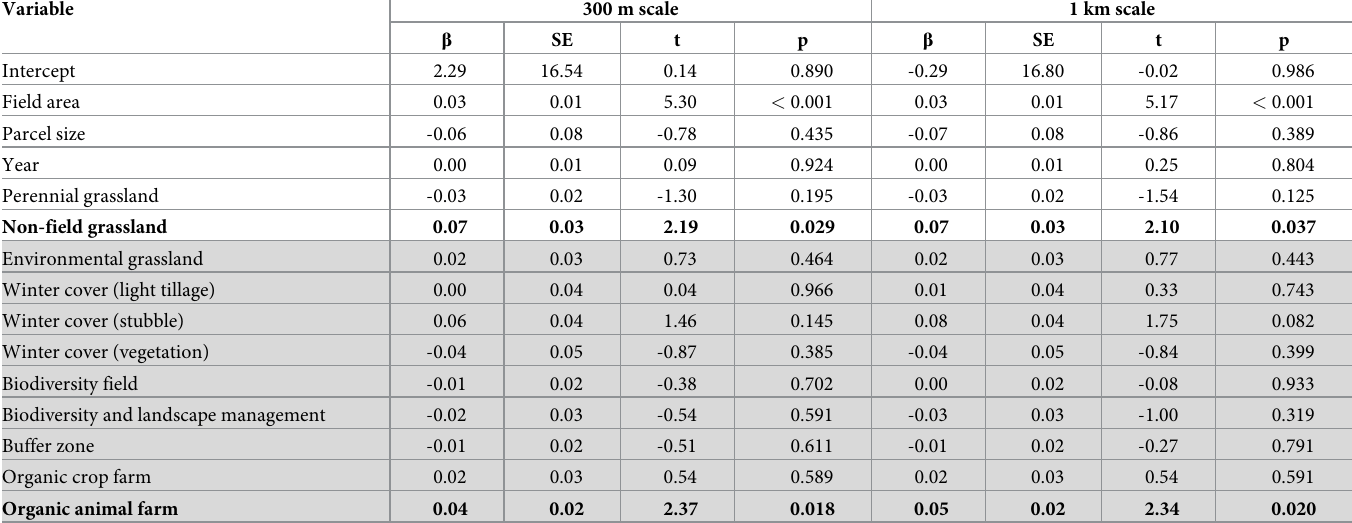
Table 2. Results of the generalized linear mixed model relating summed farmland associated bird abundance (response) with nine agri-environment scheme (AES) variables (rows highlighted in grey shade) while controlling for relevant land-use and other landscape variables as well as year. Results refer to models based at the 300m and the 1km scale (see Methods and Table 1 for more details on the model and the variables